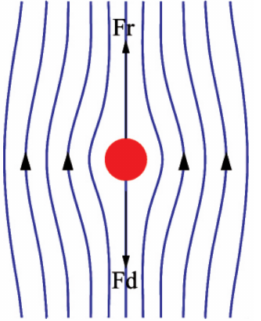
Figure 3. Force analysis of a concrete